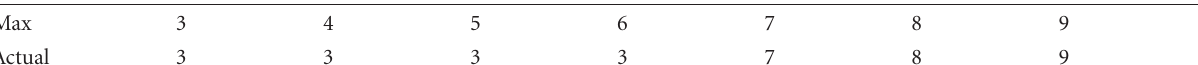
Table 4: Number of resultant clusters using Iterative G-K algorithm, fuzzy hypervolume performance measure and the maximum number of clusters shown in row 1.